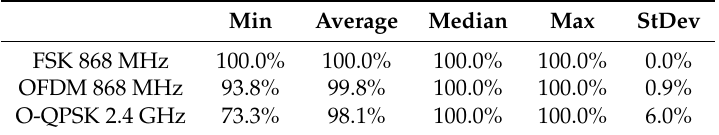
Table 3. End-to-end Packet Delivery Ratio (PDR) statistics over all motes in the network, computed over the last 15 min of the experiments.